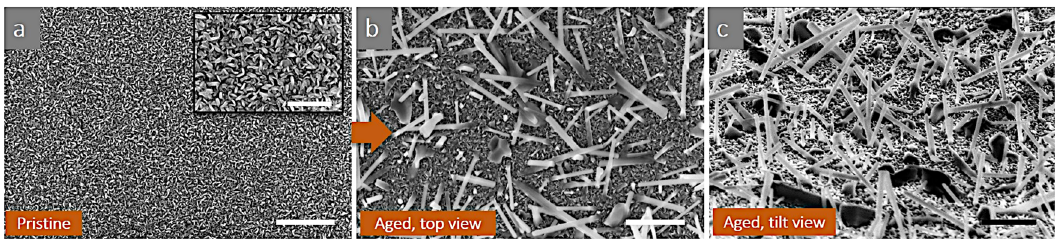
Fig. 1 Sample evolving morphology. a A top view SEM image of the grown MoS 2 sample (pristine); scale bar 1 μ m; a magni fi ed view is shown in the inset; scale bar = 300 nm. b Top view SEM image of the same sample after a long-term aging period of ~36 months. The formation of nanorods can be seen over the sample surface. c Tilt view of the sample indicating the randomly grown nanorods. Scale bars in b and c 1 μ m.